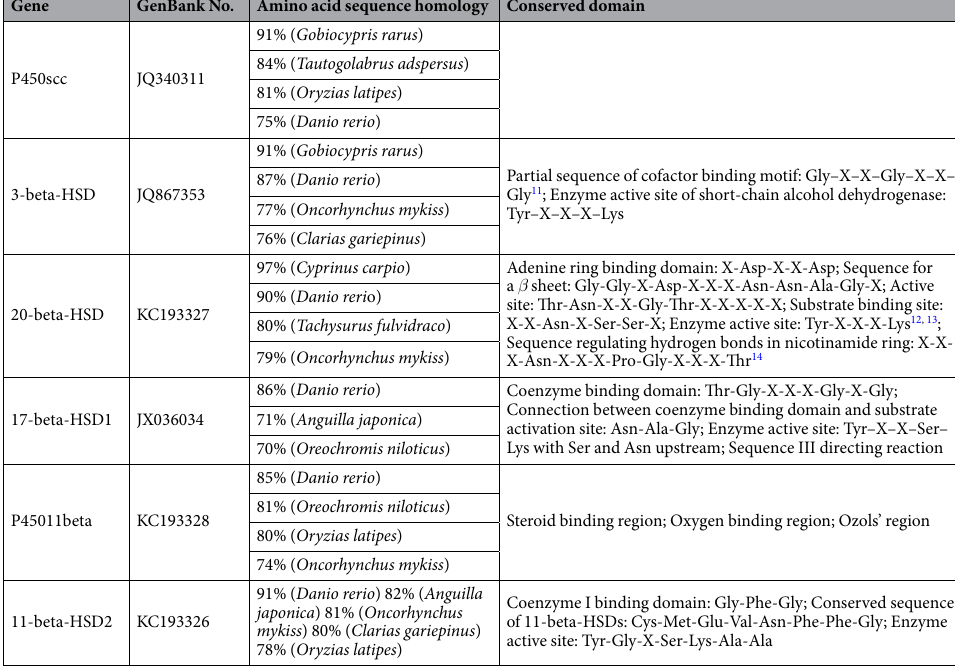
Table 1. Alignment of the deduced amino acid sequences of goldfish steroidogenesis enzyme genes with those of other animal